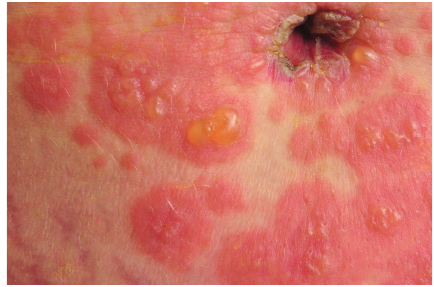
Figure 1: Periumbilical eruption in PG. Figure 2: Urticaria-like and vesicular skin lesions in neonatal